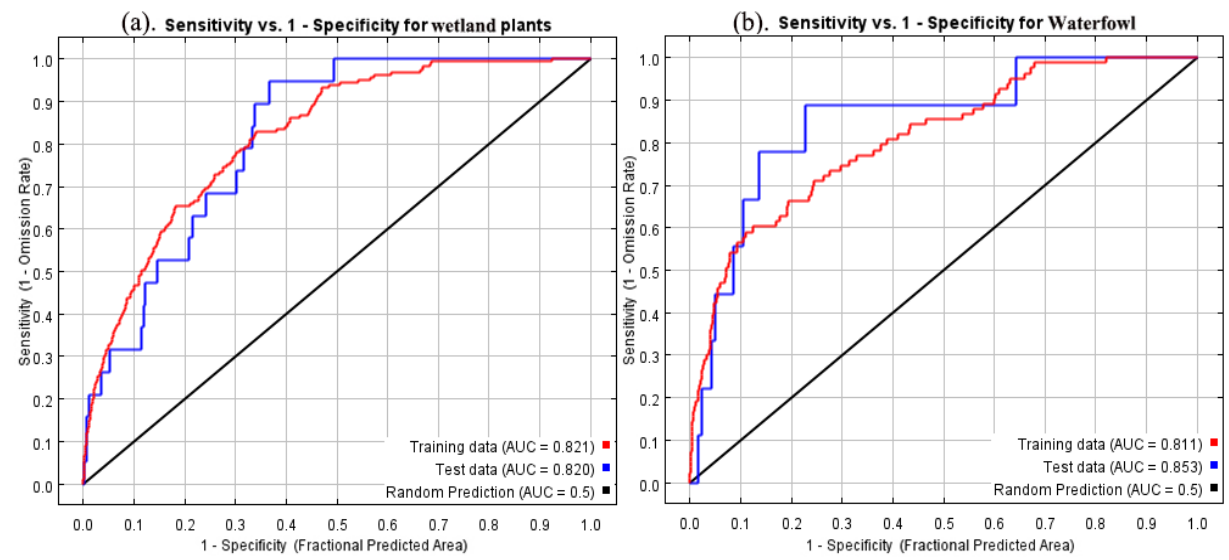
Figure 3. AUC values of ROC curves for ( a ) wetland plants and ( b ) waterfowl.